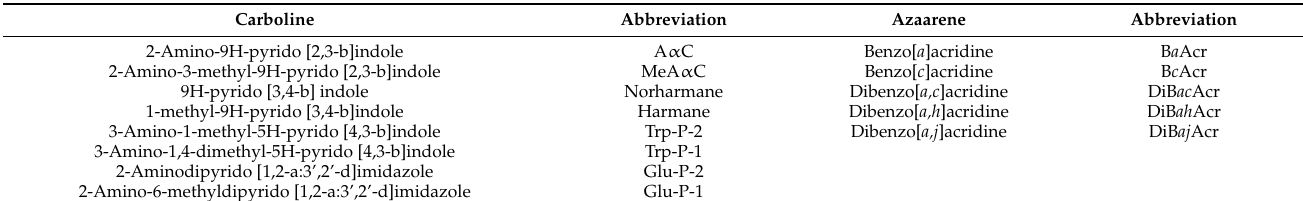
Table 1. Names and abbreviations of carbolines and azaarenes evaluated in the study. Carboline